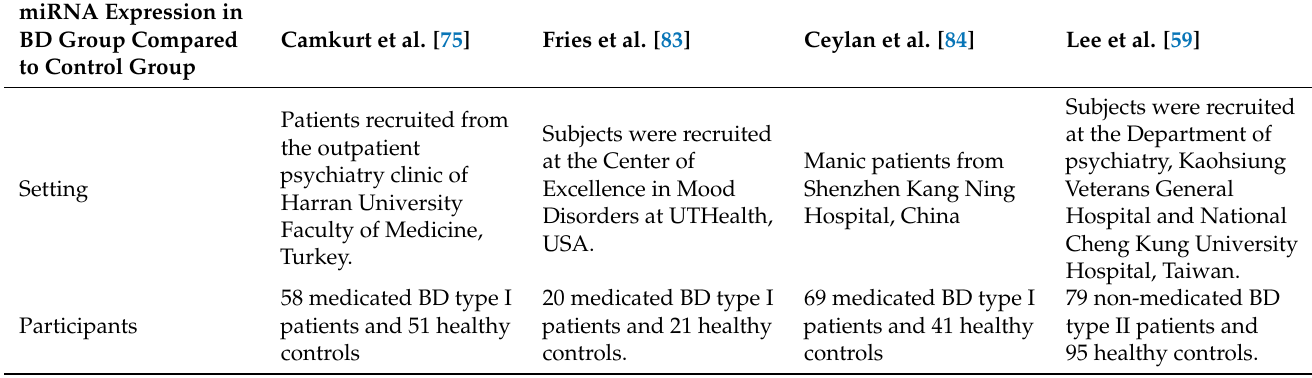
Table 1. Differentially abundant peripheral circulatory miRNAs in bipolar disorder. Combined list of circulating miRNAs with significantly altered abundance in BD patients compared to controls ( p -value < 0.05) after correction for multiple testing. miRNAs in bold are reported differentially abundant in BD patients in more than one study. SCID-1: Structured clinical interview for DSM-IV- Axis I disorders. SADS-L: Schedule for Affective Disorders and Schizophrenia. BRMS: Bech–Rafaelsen mania scale and the Hamilton depression scale. YMRS: The Young Mania Rating Scale. HAM-D: Hamilton depression scale–17. qRT-PCR: Quantitative Real